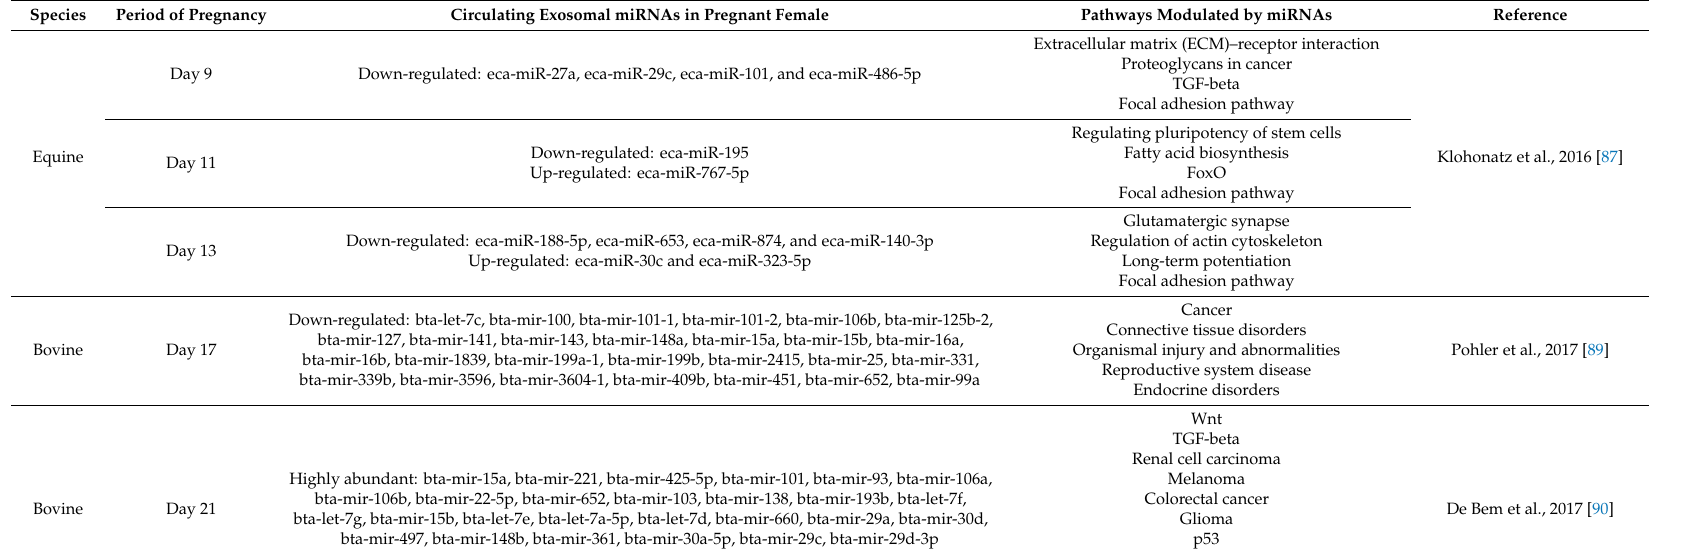
Table 2. The main published papers about extracellular vesicle-associated miRNAs in pregnant female